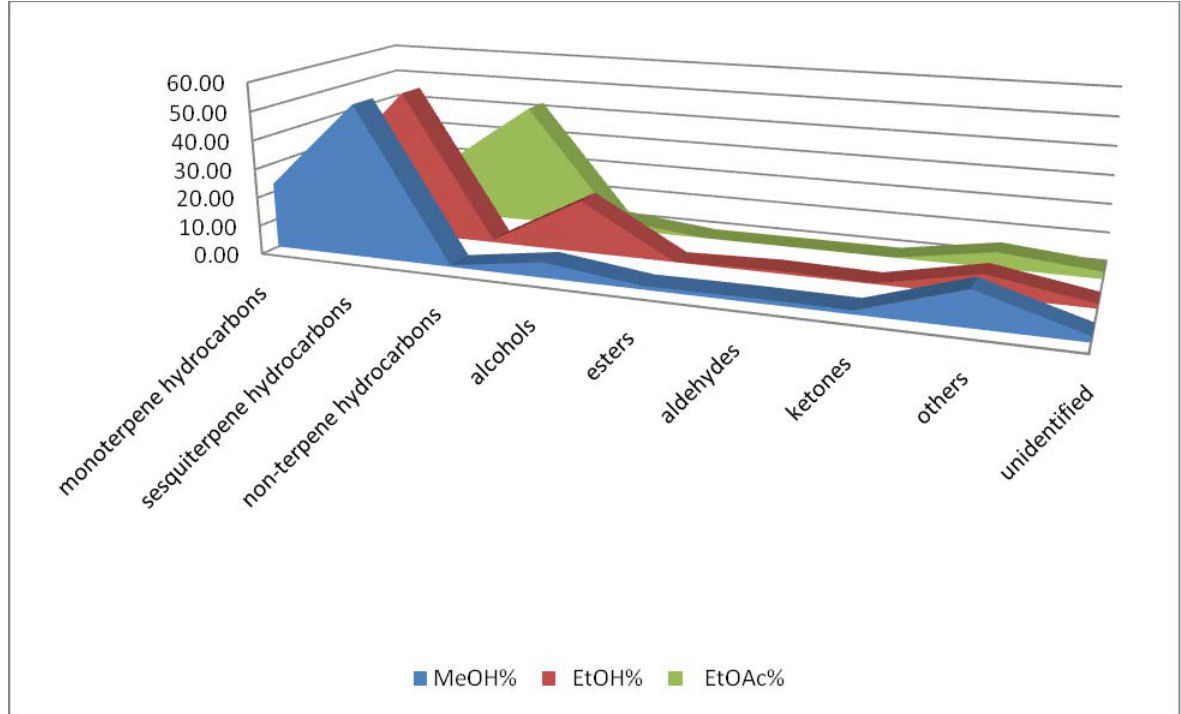
Figure 1. The chemical class distribution of the P. cordaeana